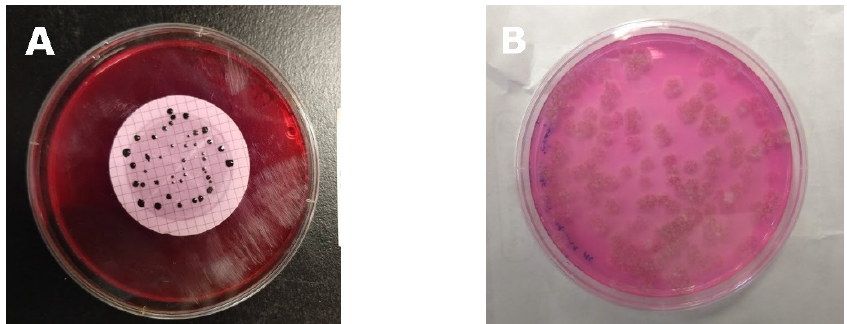
Figure 2. Enumeration of Salmonella spp. and C. gloeosporioides . ( A ) Salmonella spp. growth on XLT4 media after the membrane filtration method, ( B ) C. gloeosporioides growth on DRBC media.